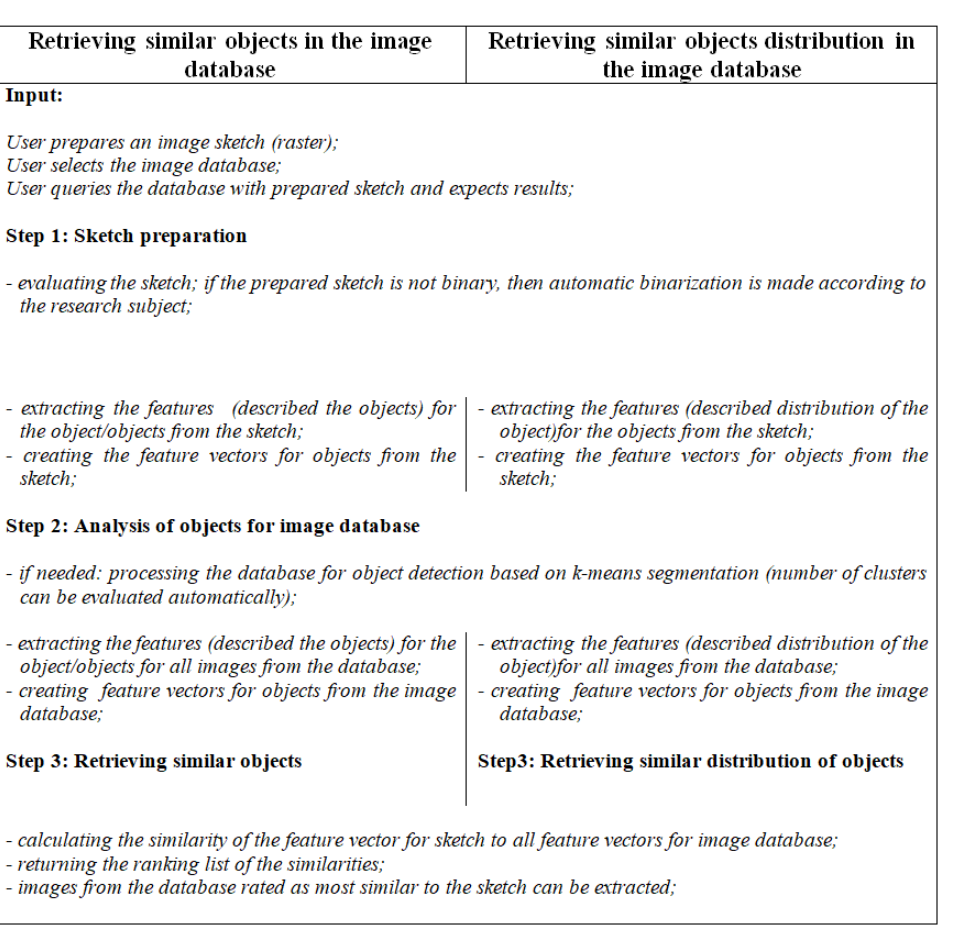
Figure 4. Algorithms of the retrieval methods of similar objects and similar distribution of